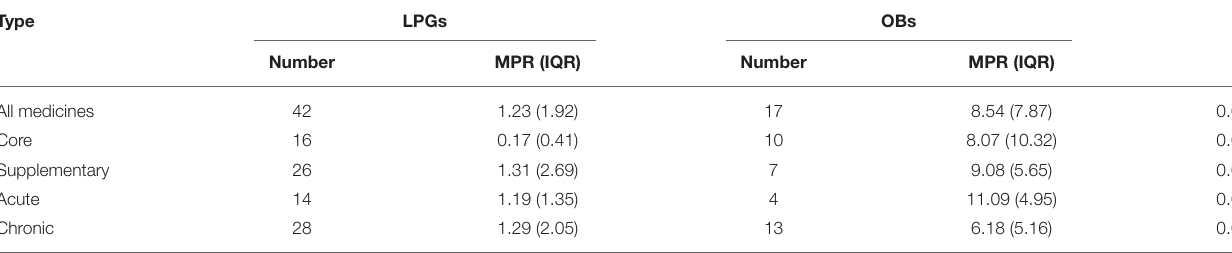
TABLE 5 | Median MPR of essential medicines in Jiangsu.